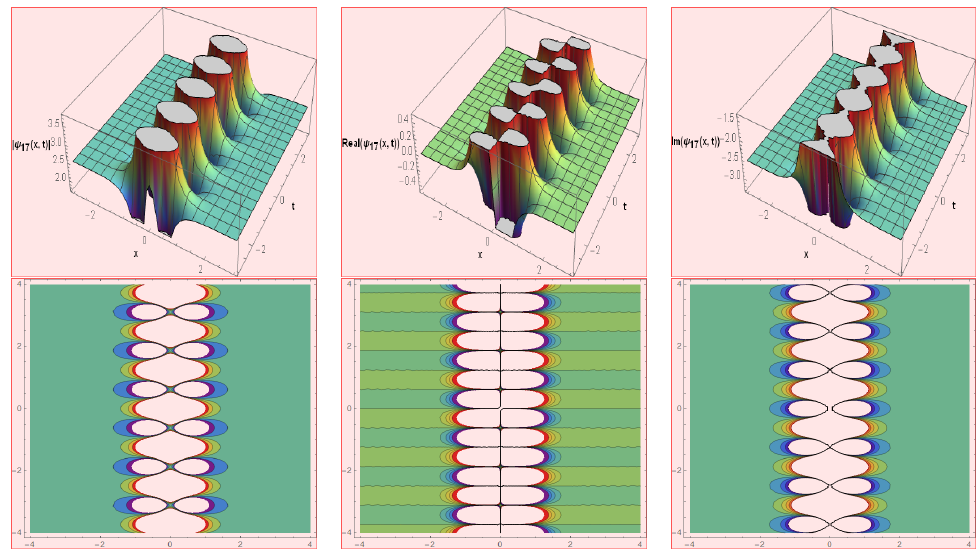
Figure 13. The absolute, real, and imaginary behavior in the shape of 3D and their corresponding contour plots are dispatched for ψ 17 ( x , t )